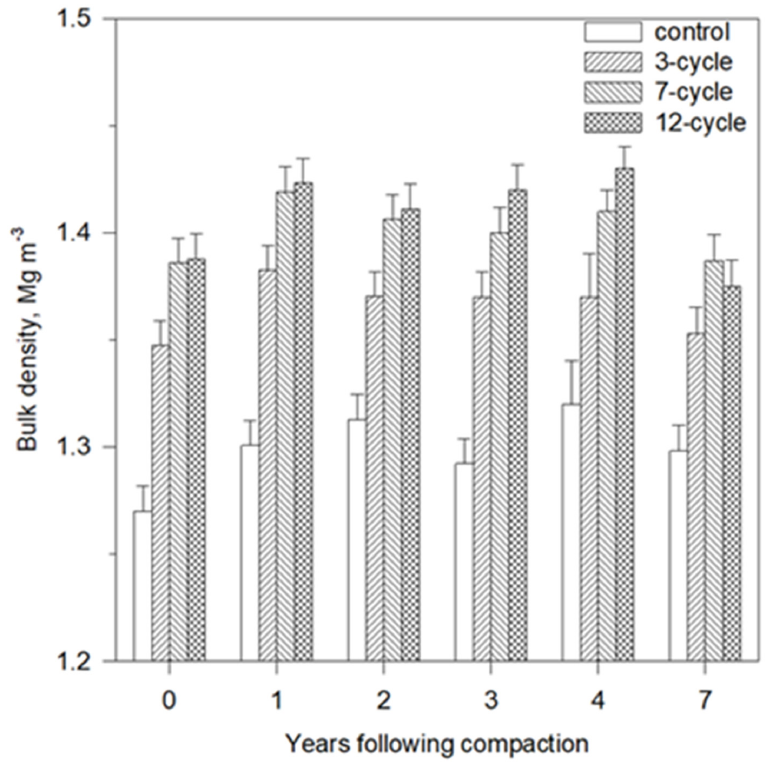
Figure 5. Mean bulk density of harvest-only (control) and 3, 7, and 12 skid cycles of soil trafficking over a period of 7 years. Each value of bulk density is the mean for the 5, 10, and 20 cm depths measured at nine sites ( n = 144; Table 2).